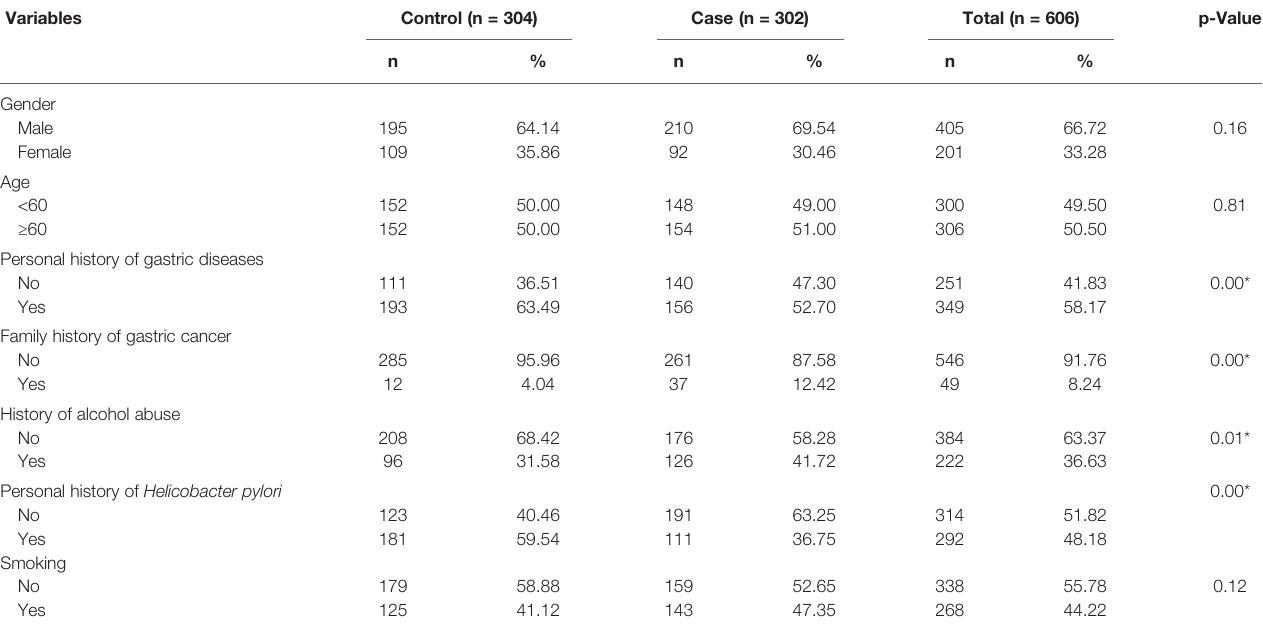
TABLE 2 | Frequency distribution of selected characteristics in gastric cancer cases and controls. Variables